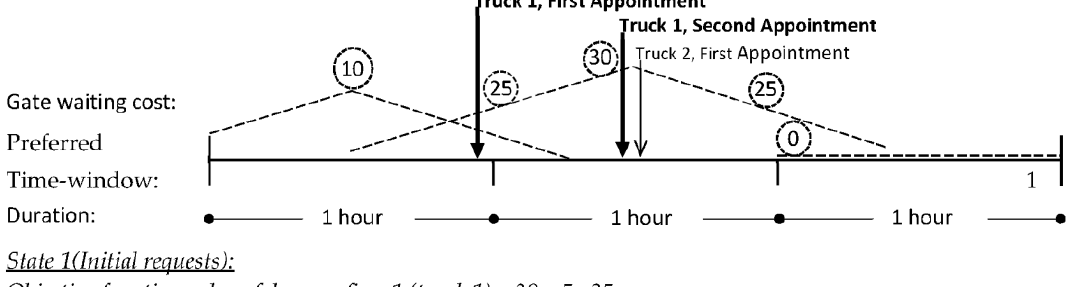
Figure 3. Solution of illustrative example using single-player TAS.